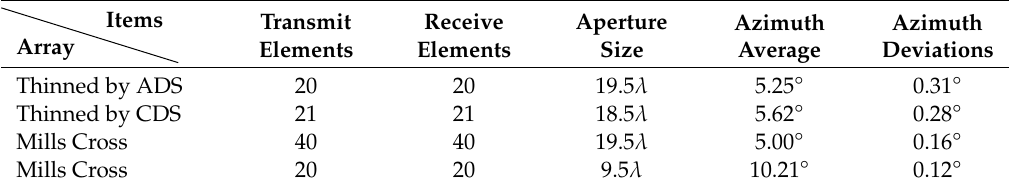
Table 3. Average values and standard deviations of azimuth resolutions of the